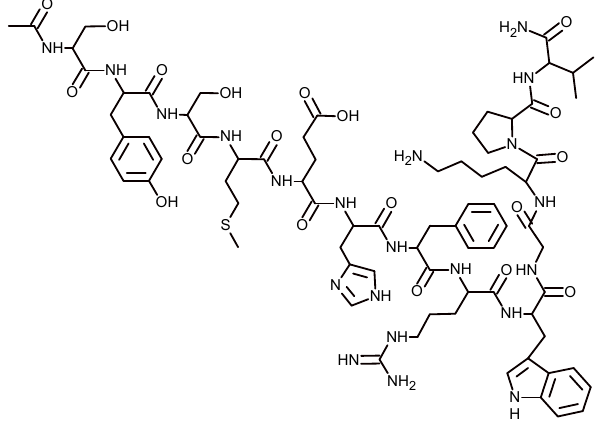
Figure 9. Chemical structure of α -melanocyte hormone.